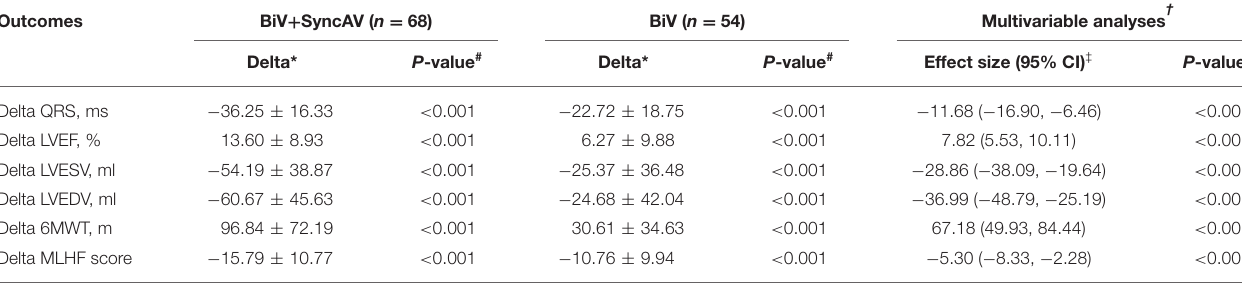
TABLE 2 | Improvement in QRS, clinical, and echocardiographic outcomes between groups. Outcomes